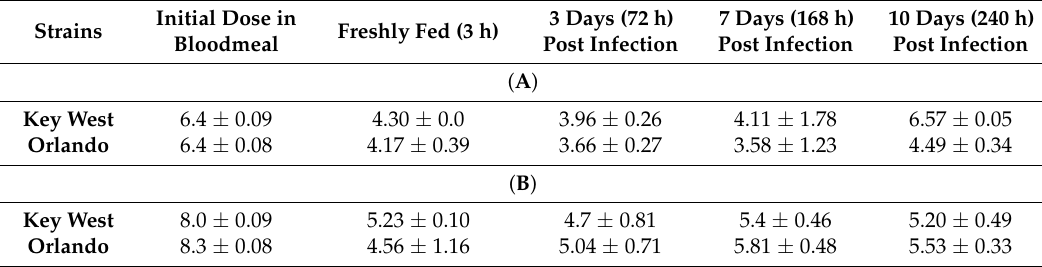
Table 3. ( A ) Zika virus titers (log10 pfu/mL) in infectious blood meals and mosquitoes for Key West and Orlando strains of Aedes aegypti . ( B ) Chikungunya virus titers (log10 pfu/mL) in infectious blood meals and mosquitoes for Key West and Orlando strains of Aedes aegypti